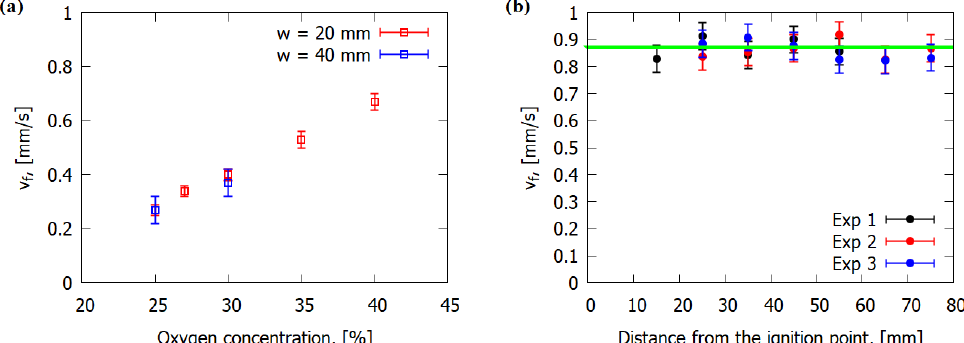
Figure 5. The influence of the slab width ( w ) on the measured ROS over 1.2 mm-thick GFRER samples ( a ). Dependence of ROS on the distance from the ignition point for 0.3 mm-thick sample, 25% O 2 ( b ). Dots of different colors correspond to different runs of the experiment. The green line corresponds to the mean value of v f .